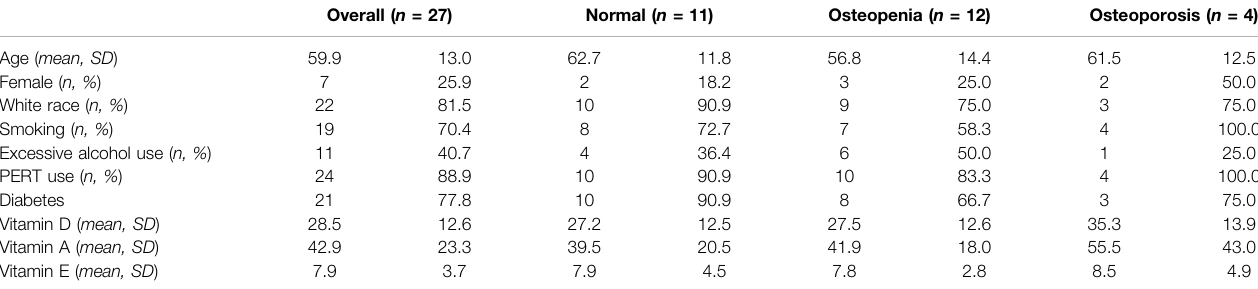
PERT, pancreatic enzyme replacement